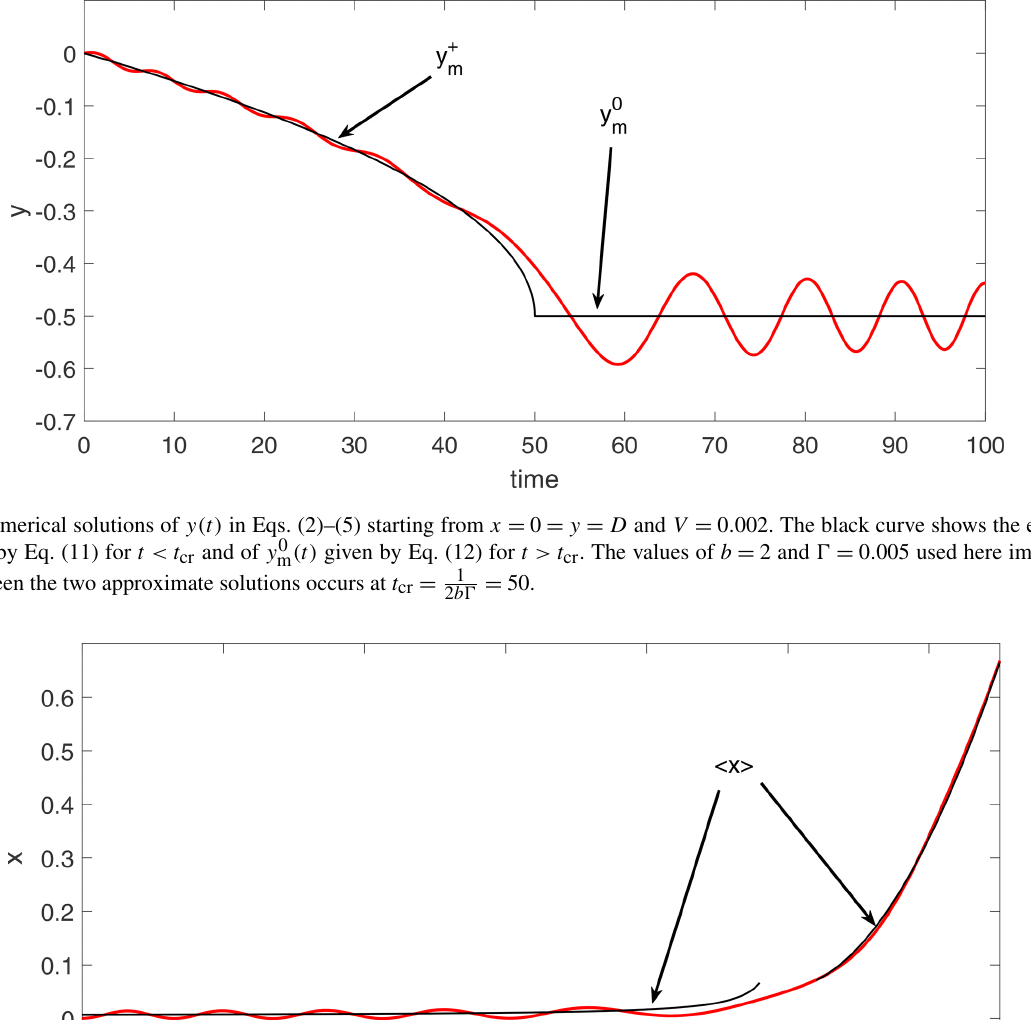
on the β plane when (cid:48) (cid:54)= 0 is slower than in the inertial case, (cid:48) = 0, and it is independent of the sign of (cid:48)